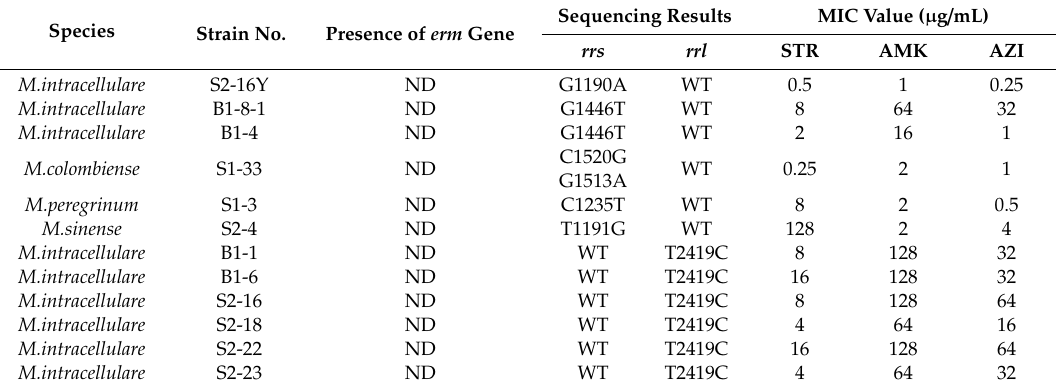
Table 3. Mutations in the rrs and rrl genes identified by sequencing. Species Strain No. Presence of erm